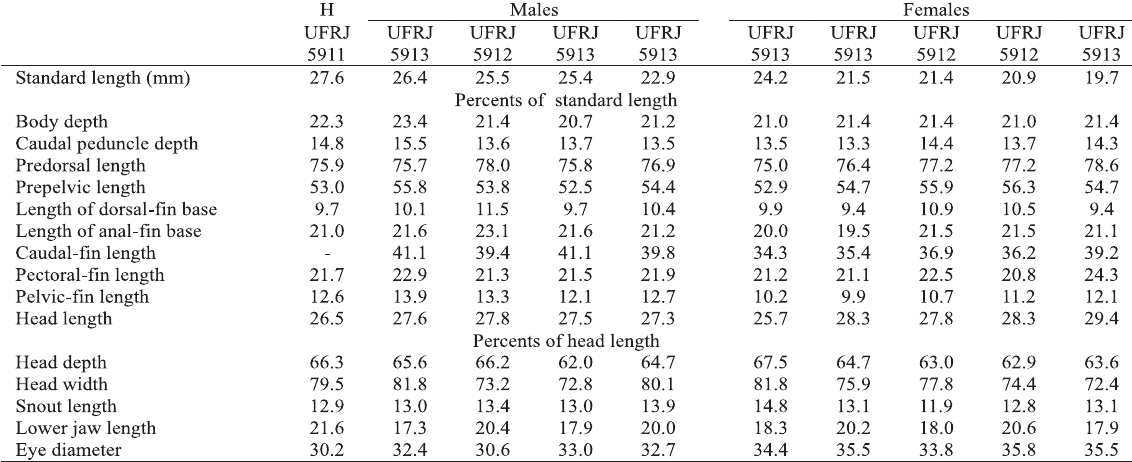
Table 2. Morphometric data of the holotype (H, male) and paratypes of Rivulus cyanopterus .